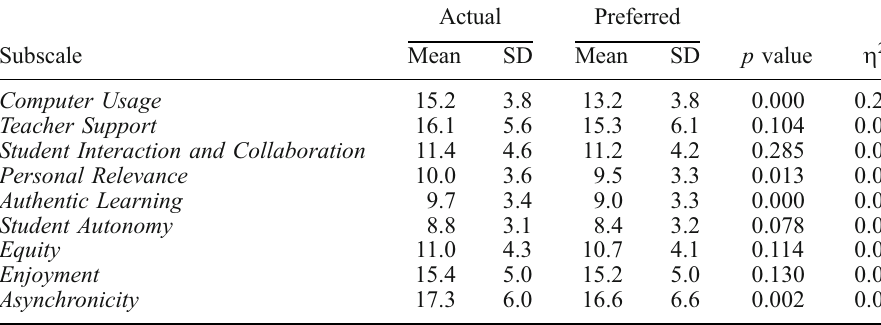
Table 4. Overall participant actual and preferred for OLES